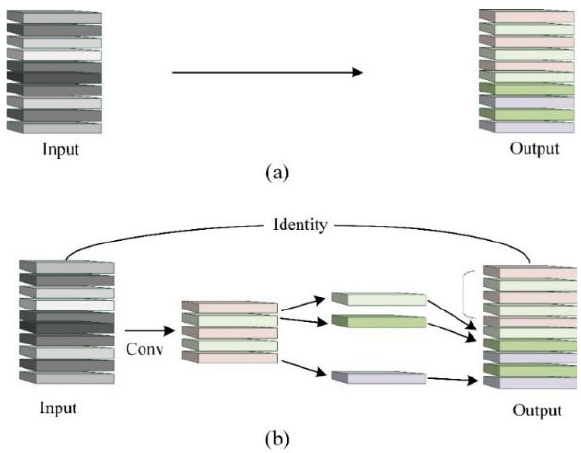
Figure 7. Two convolution methods: ( a ) ordinary convolution ( b ) ghost convolution.